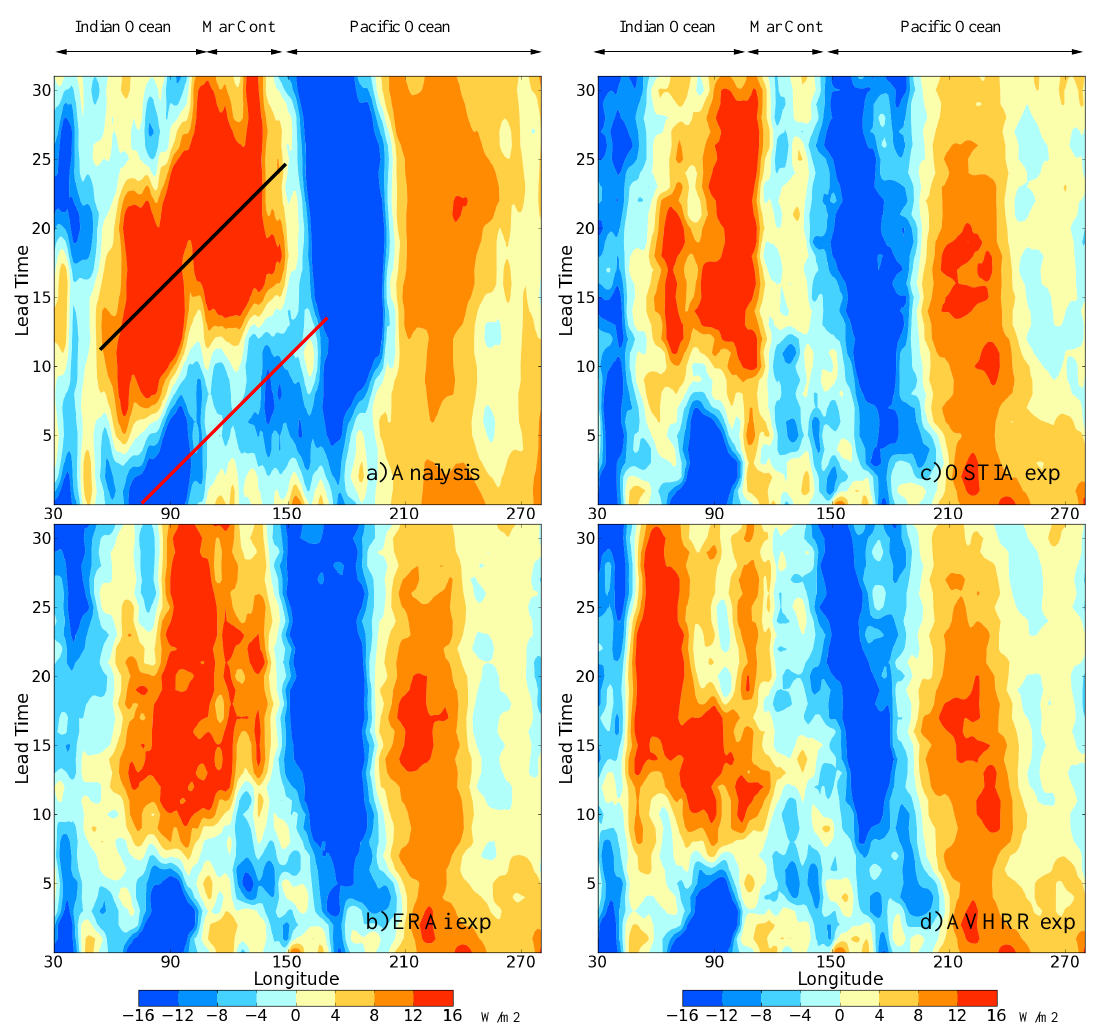
Fig. 6. Longitudinal hovmoller diagrams of the ensemble-mean OLR anomalies (in Wm − 2 ) averaged between 10 ◦ S and 10 ◦ N for starting dates when the convective centre of the MJO is over the Indian Ocean. Negative anomalies indicate active convection, while positive anoma- lies indicate suppressed convection. (a) ERA interim reanalysis, (b) ERAi experiment, (c) OSTIA experiment, (d) AVHRR experiment. The red and black lines indicate the propagation of the active and suppressed phases of the MJO,